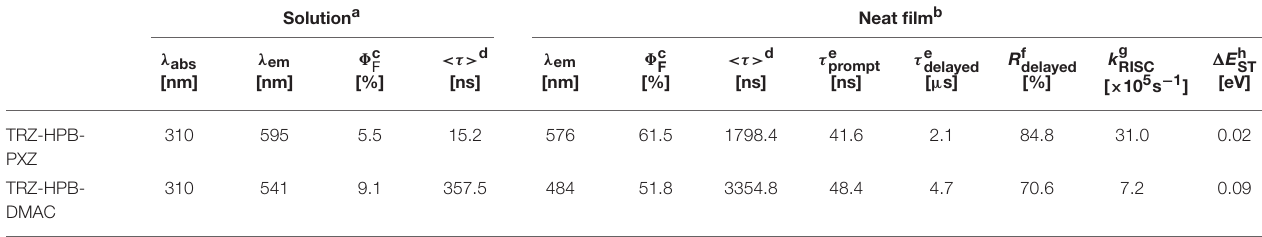
TABLE 1 | Photophysical property of TRZ-HPB-PXZ and TRZ-HPB-DMAC. Solution a